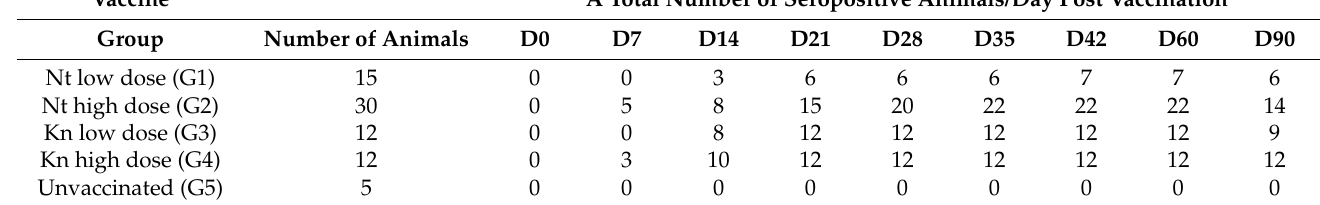
Table 5. Percentage of positive animals by